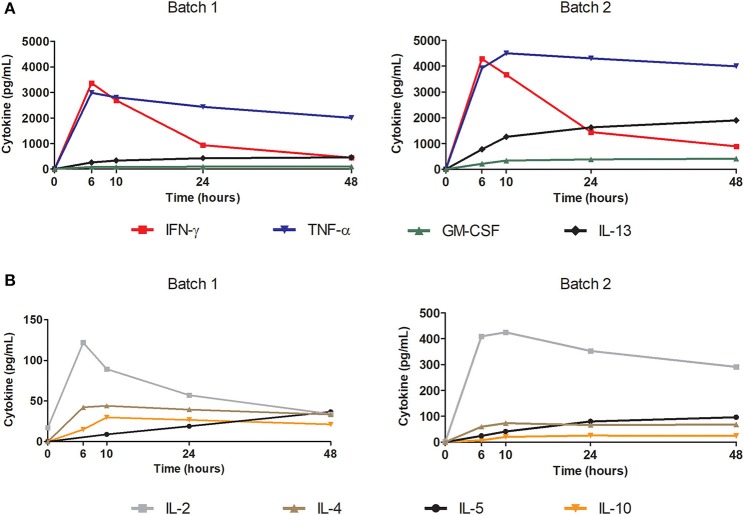
Polyfunctionality of the final thawed product tested using cytokine secretion kinetics after antigenic stimulation. Test performed with Luminex technology. Cytokines tested: IL-2, IL-4, IL-5, IL-10, IL-12 (p70), IL-13, IFN-γ, GM-CSF, and TNF-α. Cells were stimulated with pp65 50 ng/mL at a cell concentration of 1E+06 cells/mL in a 96-well plate. Graphs show the kinetics of the secreted cytokines in the supernatant (pg/mL) at each time: 0, 6, 10, 24, and 48 h. (A) Representation of secretion kinetics for cytokines IL-13, IFN-γ, GM-CSF, and TNF-α from 2 batches of final product. (B) Representation of secretion kinetics for cytokines IL-2, IL-4, IL-5, and IL-10 from 2 batches of final product.